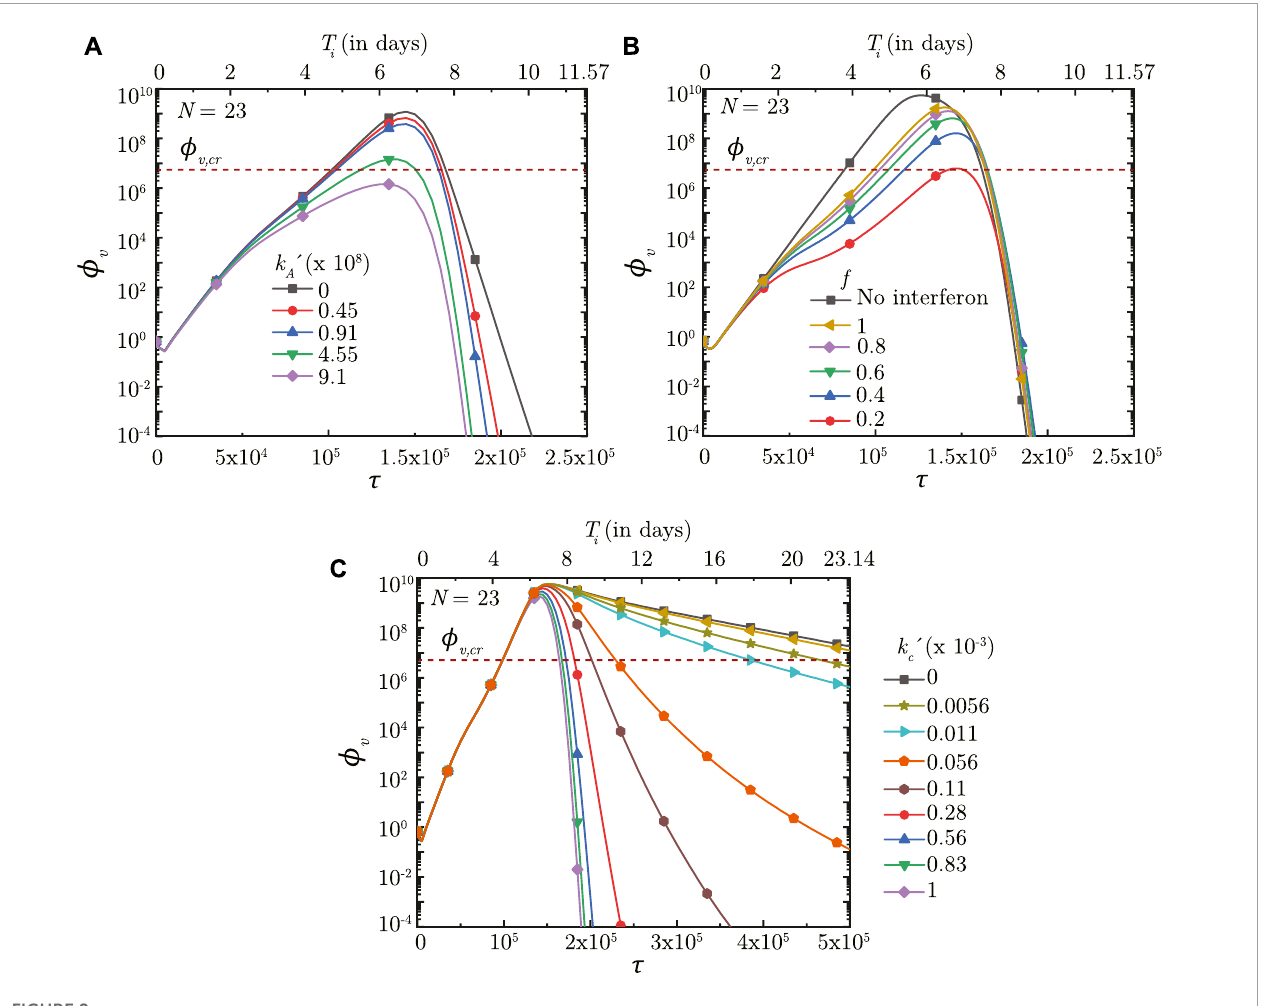
FIGURE 8 Temporal change in dimensionless virus concentration ( ϕ v ) at N = 23 (deep lung) with change in (A) binding affinity of antibodies ( k ′ requirement for halving virus production ( f ) , and (C) rate at which cytotoxic T-lymphocytes eliminate the infected cells ( k ′ c ) . The results are shown with respect to dimensionless time ( τ ) as well as a dimensional time ( T i ) post infection onset with the breathing time period ( T b = 4s) considered for obtaining the dimensional time (see Eq. 7 ). The dotted line indicates the critical viral load ( ϕ v , cr ) in the deep lung required for pneumonia onset (Fajnzylber et al.,